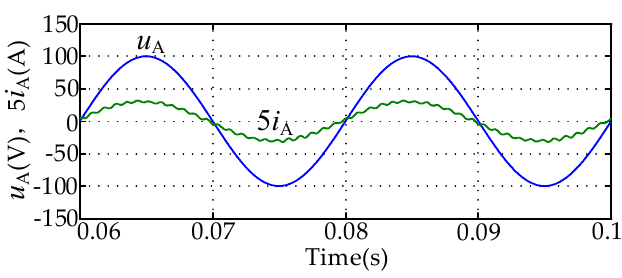
Figure 10. Input phase voltage and current.